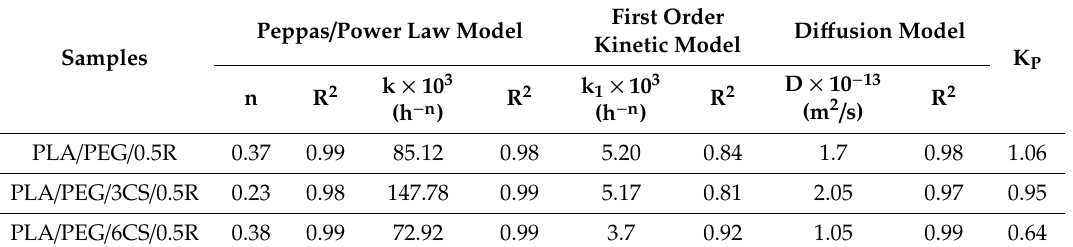
Table 6. Kinetic parameters of the bioactive compounds release from plasticized PLA based materials containing CS and rosemary extract.